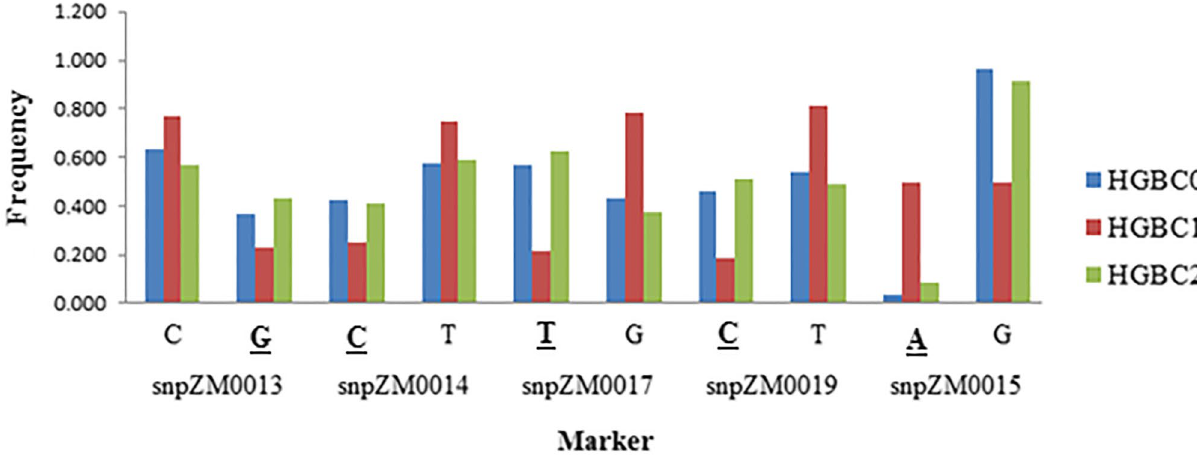
Figure 2. Allele frequency changes of crtRB1-KASP specific PVA marker alleles in HGB and its derived cycles. *The favorable alleles are bolded and underlined.